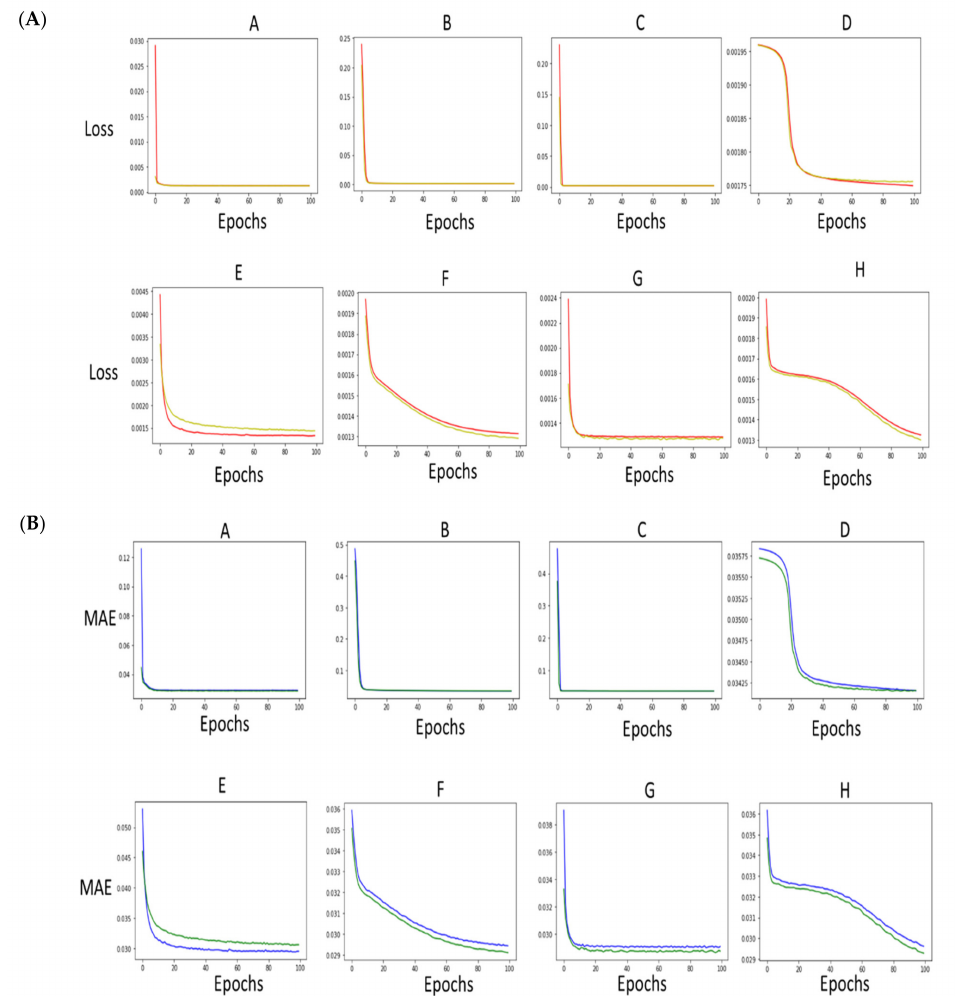
Figure 3. Loss and mean absolute error functions of the extraction network in Adera2.0 workflow. ( A ) Models A, E, F, G, and H achieve the lowest loss. Models B, C, D and H show the highest loss. Green is utilized for the loss function, while red is used for the validation loss calculations. ( B ) Model A achieves the lowest MAE value. The mean absolute error is in blue, while the validation of the MAE curve is in green. It is worth noting that the MAE validation values are lower than their respective MAE training values. The MAE is calculated over any given dataset. The dataset is split randomly into training and validation datasets with a ratio of 0.61:0.39. Thus the size of the validation dataset is smaller, resulting in slightly lower MAE values compared to the MAE values resulting from the training